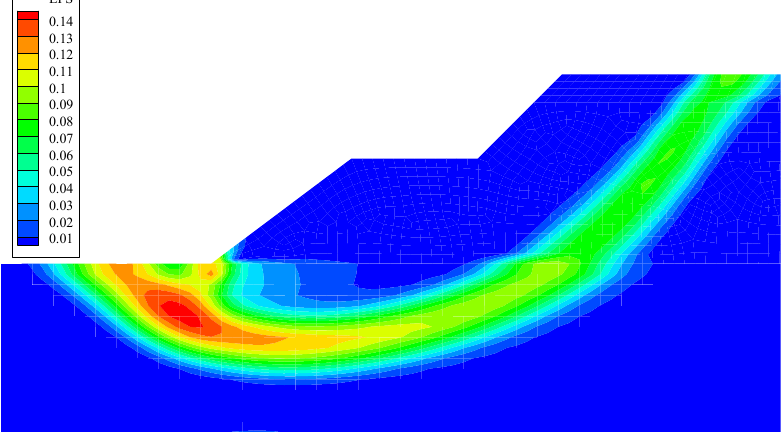
Figure 9. Distribution of equivalent plastic strain at the top corner of the